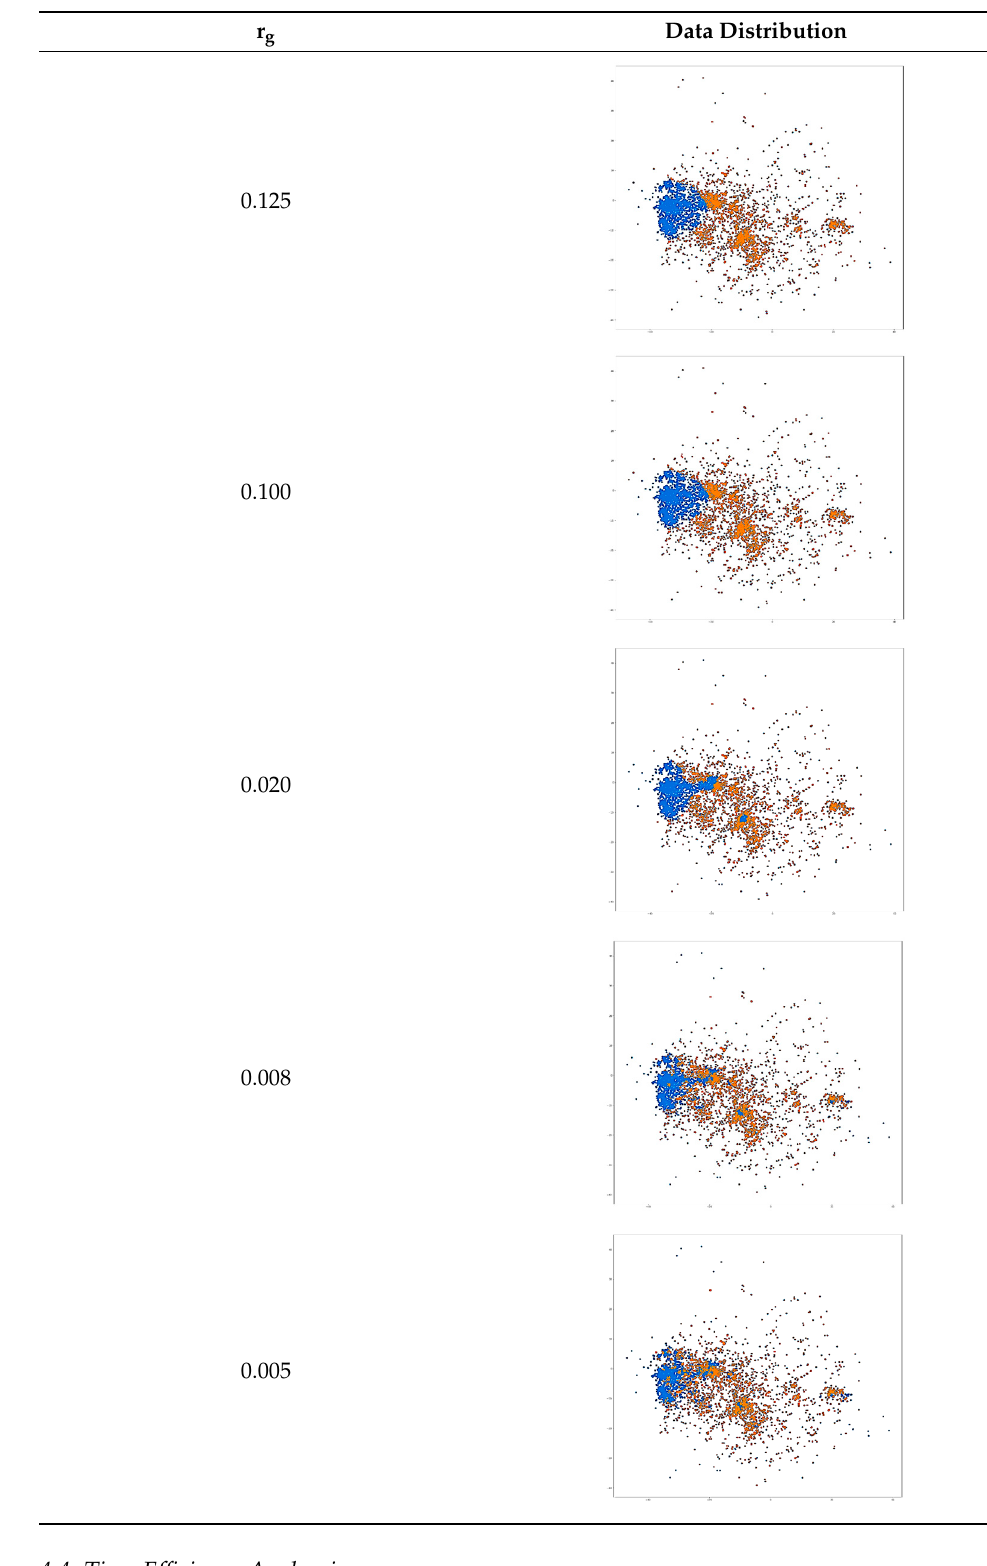
Table 5. Data distribution selected by low-DC (3000 data of class number 0).